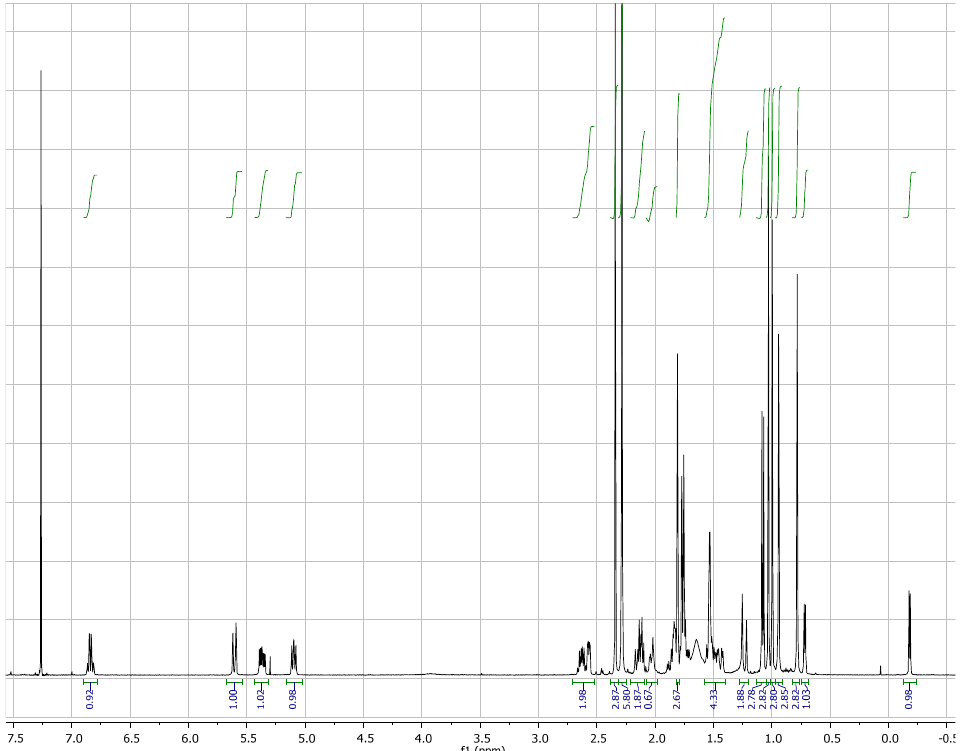
Figure A2. 1 H NMR spectrum (400 MHz, CDCl